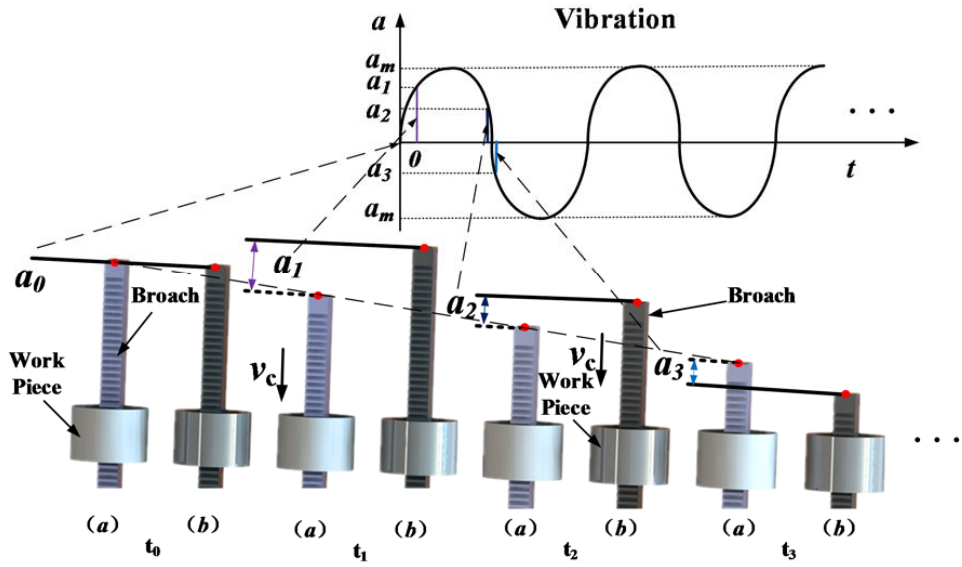
Figure 1. The process of ( a ) CB, and ( b ) HVAB.